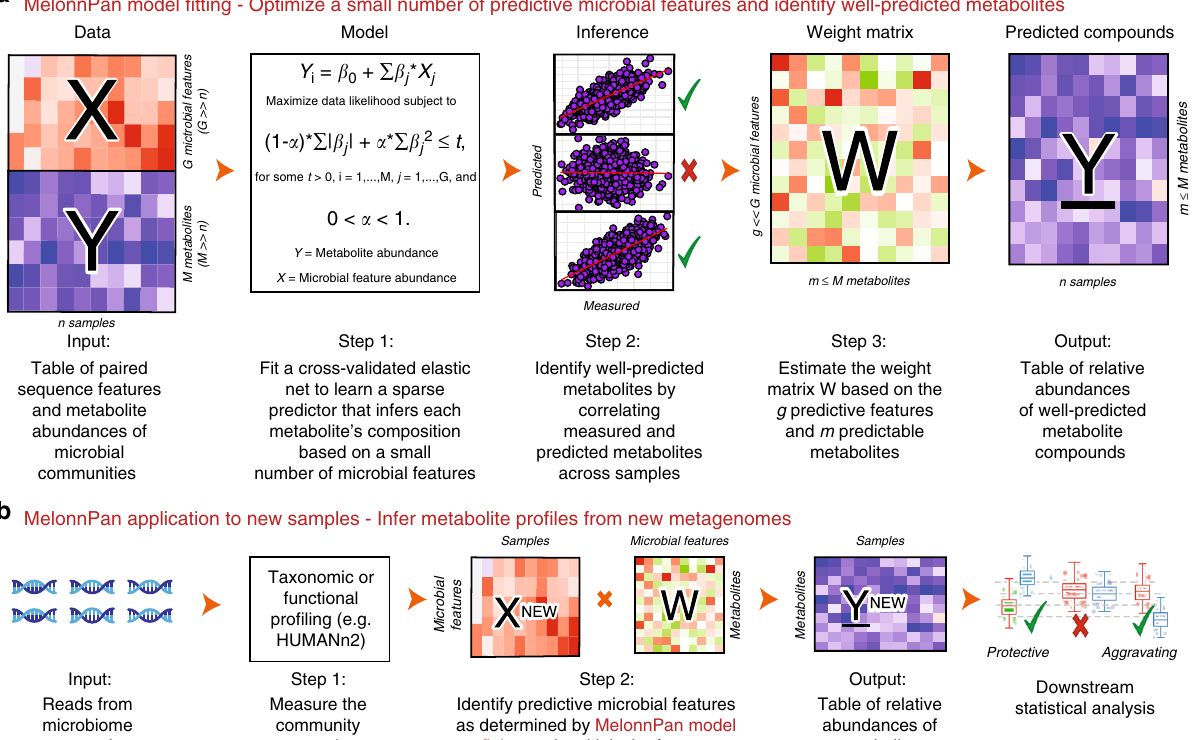
Fig. 1 MelonnPan is a predictive model inferring microbial community metabolite features from amplicons or metagenomes. a The MelonnPan model can be trained to infer metabolite pro fi les for a particular microbial community type given, fi rst, training data consisting of paired metagenomes ( X ) and metabolomes ( Y ) from the environment of interest. The model is fi t beginning with microbial sequence features derived from training metagenomes. It uses an elastic net regularized regression, per metabolite, to identify a minimal set of microbial features whose abundances predict that metabolite. These individual learners are fi rst checked using cross-validation, and poorly fi t metabolites (Spearman correlation coef fi cient between measured and predicted metabolite abundances across samples <0.3) are fl agged. b The sequence features ’ coef fi cients ( W ) for remaining, well-predicted metabolites are saved and can be applied to new metagenomes to predict the associated metabolite features ( Y , in units of relative abundance), which can be utilized for downstream epidemiological